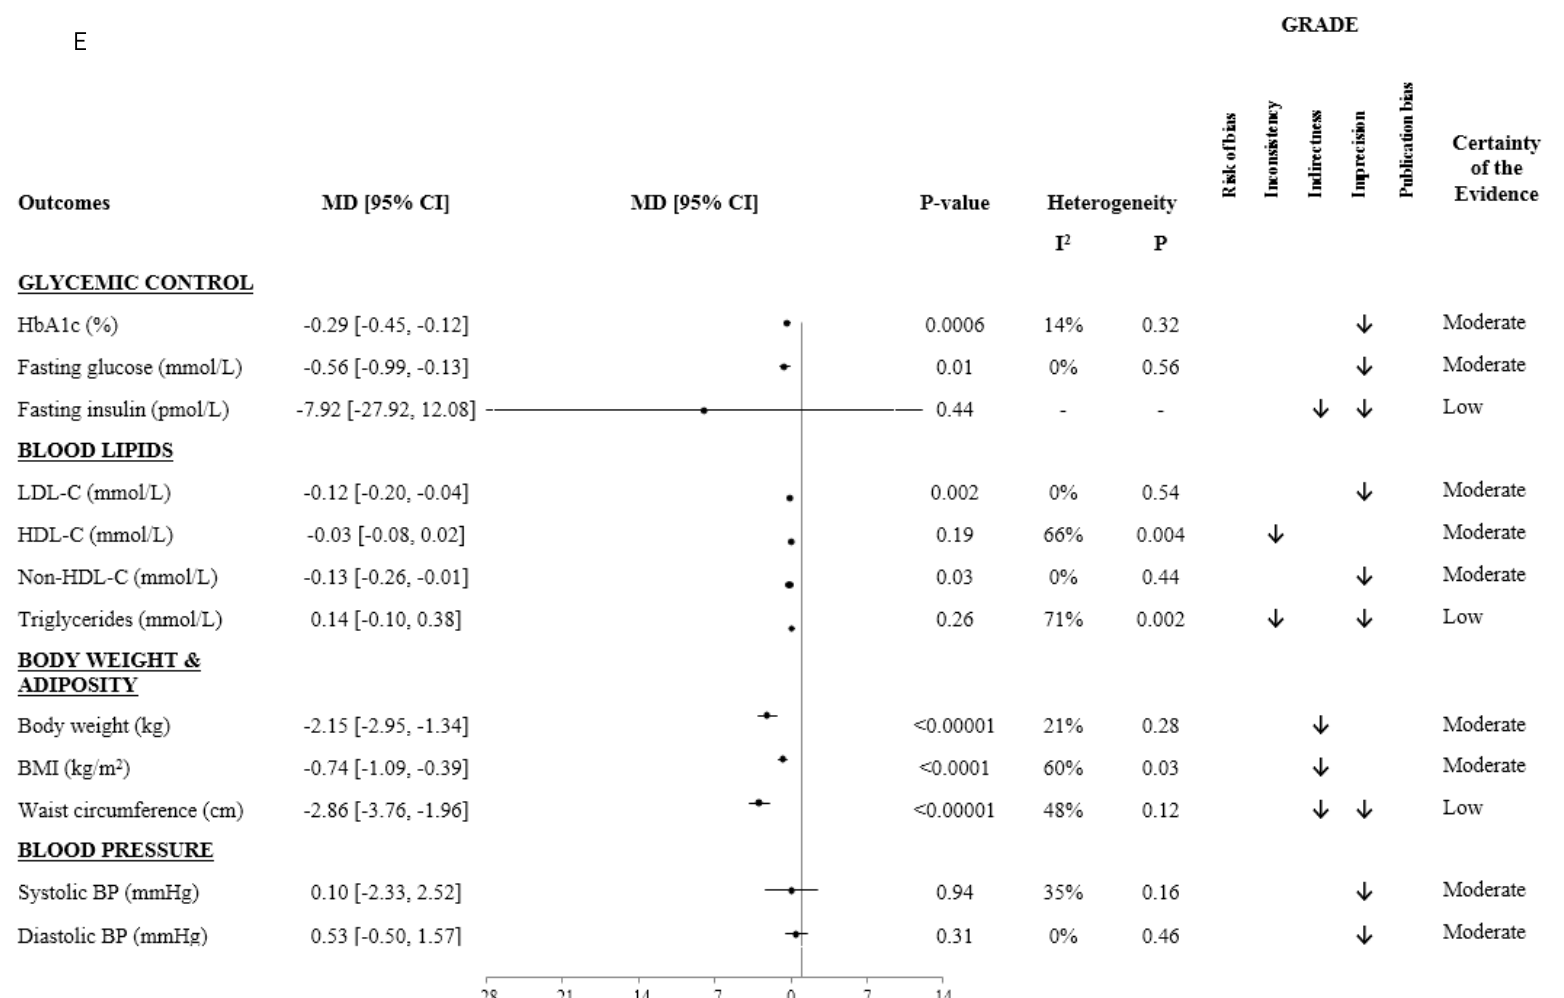
Figure 3. Summary and GRADE of the pooled e ff ect estimates of prospective cohort studies, randomized controlled trials, and systematic reviews and